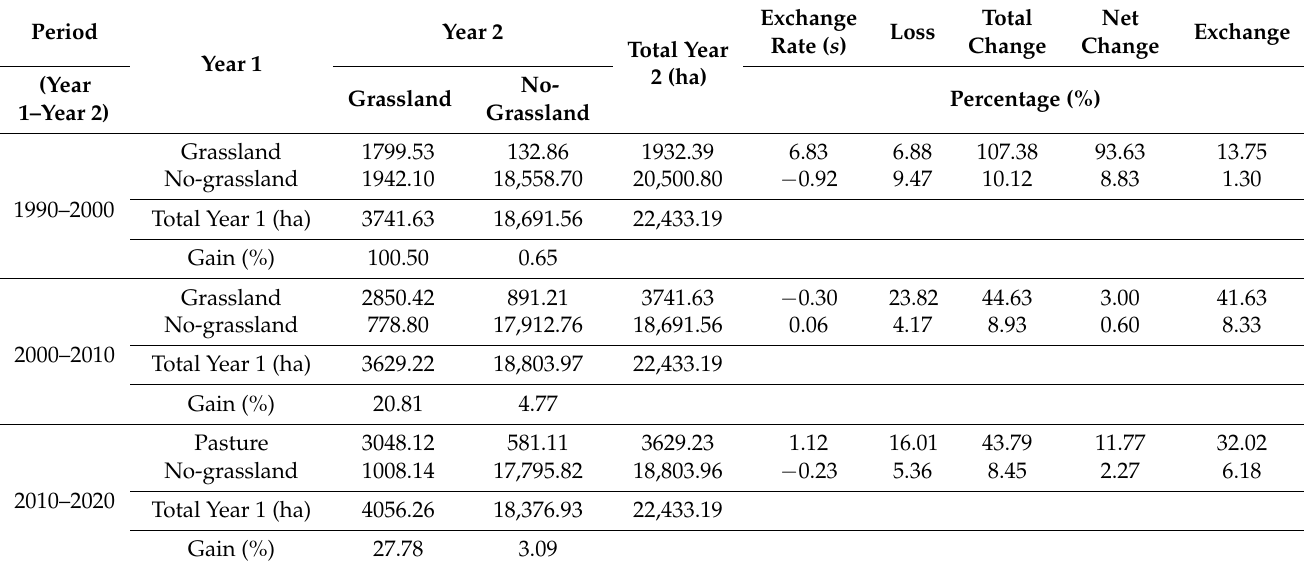
Figure 7. Area of grassland and no-grassland in 1990, 2000, 2010 and 2020 in the Ventilla micro-watershed. In this study, it was deduced that the rates estimated for the periods P1 (1990–2000), P2 (2000–2010) and P3 (2010–2020) presented marked change dynamics between grassland and no-grassland. The changes that were made in P1 included the increase in grassland (6.83%) and the reduction in no-grassland ( − 0.92%). This behavior showed the increase in grassland with respect to the reduction in non-grassland in the Ventilla micro-watershed. However, in P2, there was a − 0.30% reduction in grassland and a 0.06% increase in no- grassland. P3 followed the same patterns as P1, increasing by 1.12% and decreasing by − 0.23% for grassland and no-grassland, respectively (Table 5). Table 5. Matrix of cross-tabulation, rate of change and indices of changes for grassland and non- grassland in the Ventilla micro-watershed during three periods of analysis (area in ha and